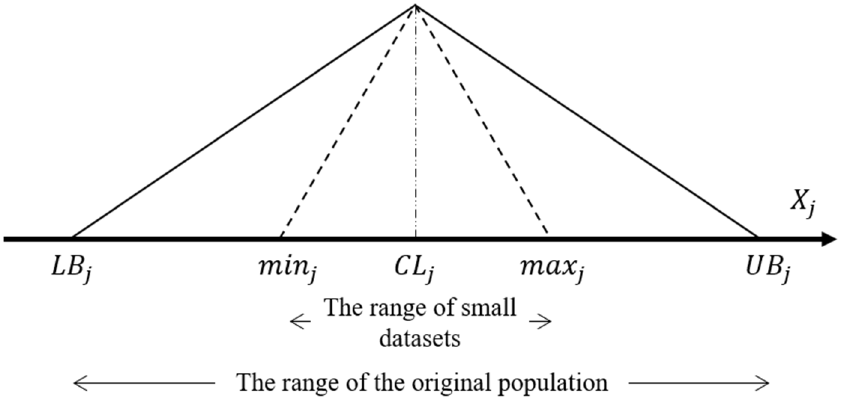
Figure 3. The possible population range of MTD.